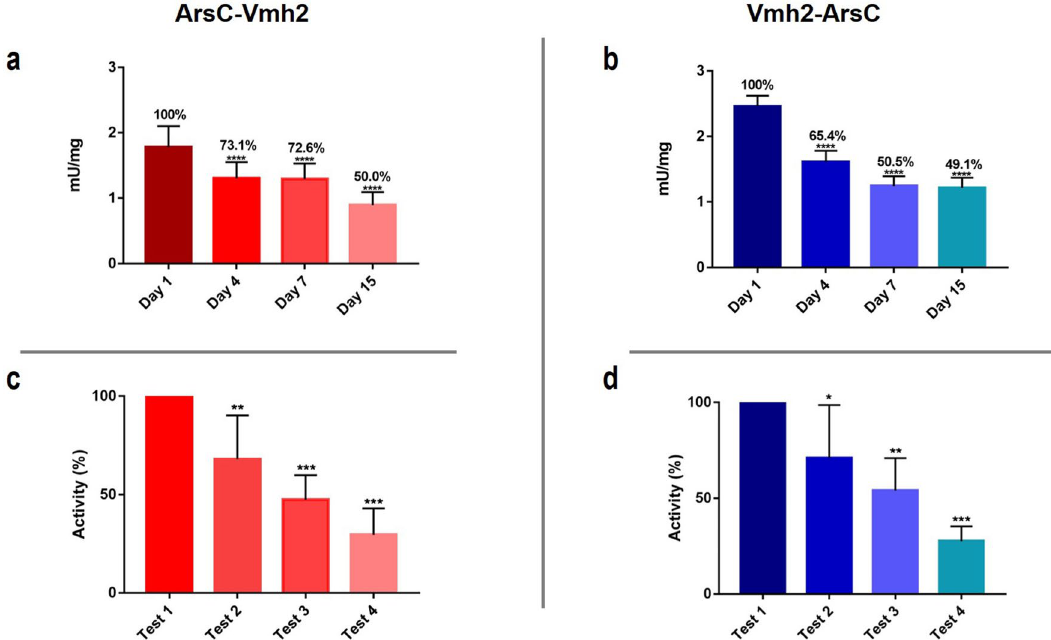
Figure 3. Stability evaluation of immobilized ArsC-Vmh2 (red) and Vmh2-ArsC (blue). ( a , b ) Functional stability of ArsC-Vmh2 and Vmh2-ArsC stored at 4 °C up to 15 days. ( c , d ) Residual activity of ArsC-Vmh2 and Vmh2-ArsC after n assays on the same immobilized proteins. Statistical analysis was performed through the ordinary one-way ANOVA on GraphPad Prism 7.00; significant differences are indicated as: * p < 0.05; ** p < 0.01; *** p < 0.001; **** p < 0.0001.